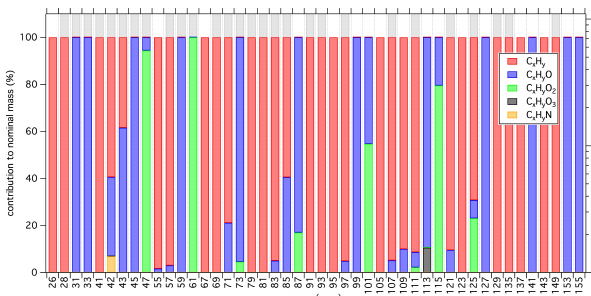
Figure 10. PTR-TOF mass contributions for all the masses that showed ambient signal during UBWOS2013. The grey bars on top indicate the masses that were monitored with the